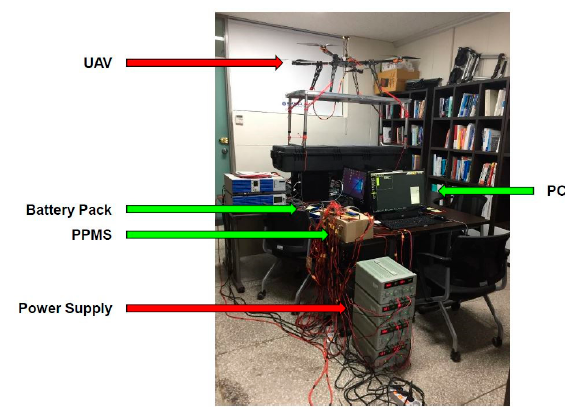
Figure 9. Experiment setup.